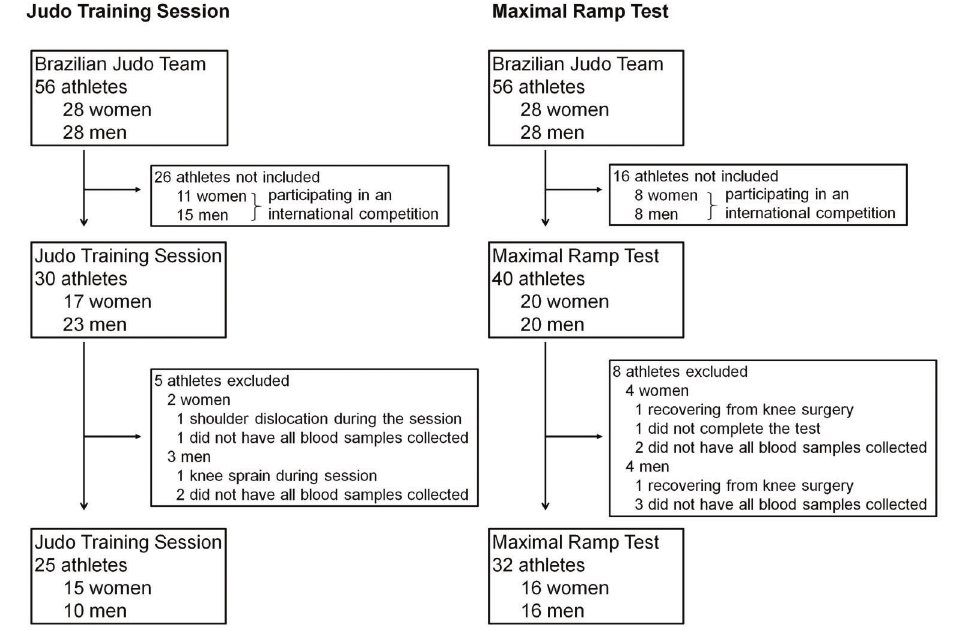
Figure 1. Flow diagram of the subjects included in this